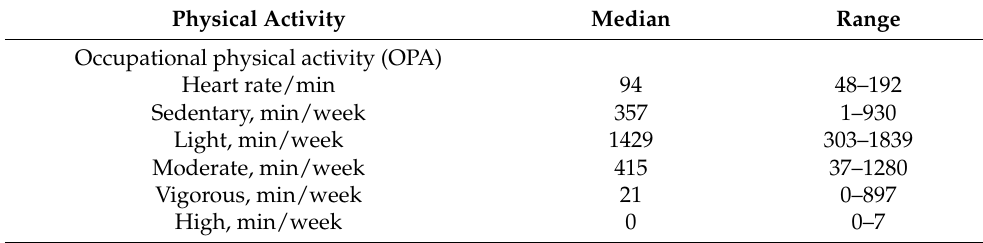
Table 5. Median heart rate and minutes of directly measured occupational physical activity and physical activity outside of work during a week ( n =